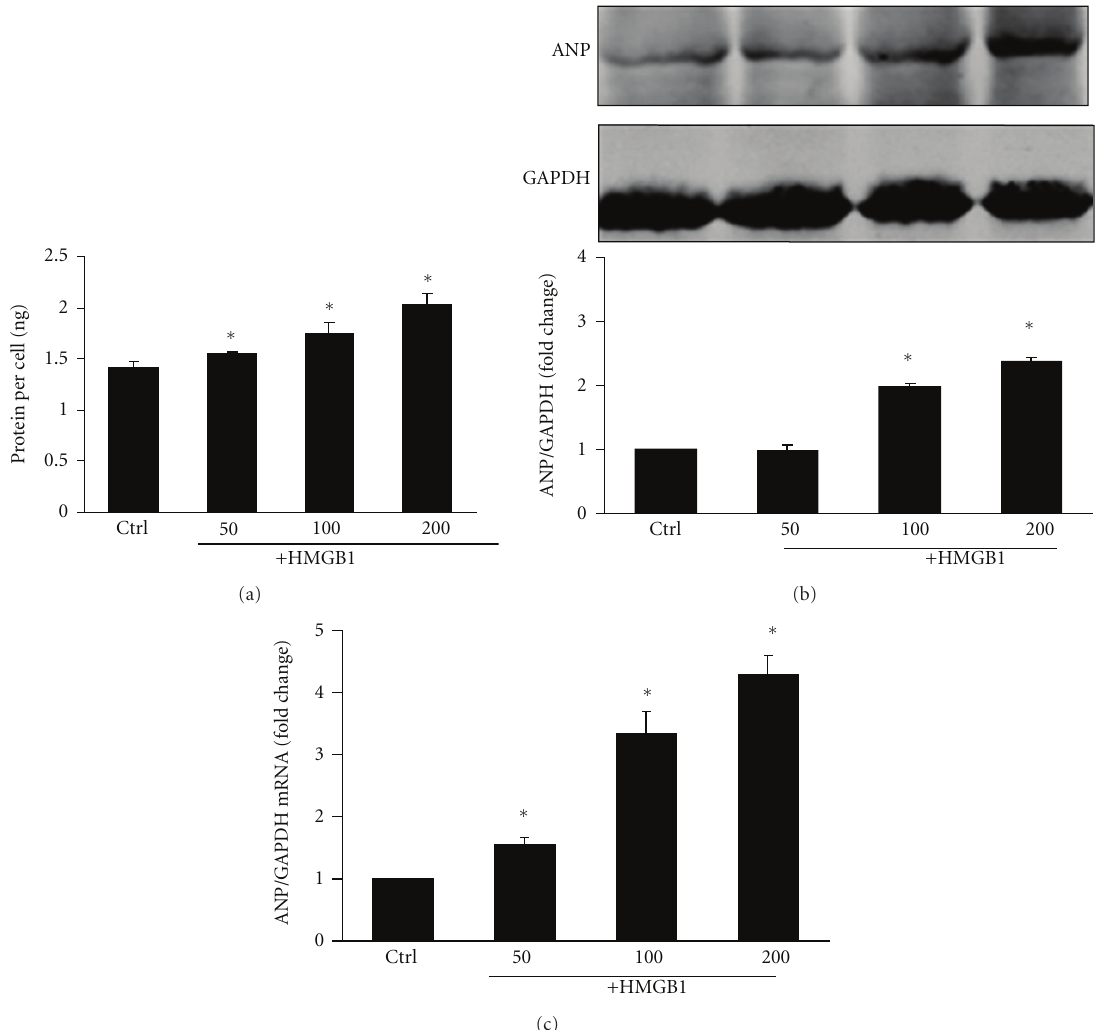
Figure 1: E ff ect of di ff erent concentrations of HMGB1 (50 to 200 ng/mL) on NRVM protein synthesis and ANP expression over 24hours. (a) NRVM protein synthesis was determined by measuring protein content per cell. (b) Expression of ANP protein in NRVMs was determined by Western blot analysis, and the integrated optical density (IOD) of ANP expression bands was analyzed. (c) Expression of ANP mRNA in NRVMs was determined by real-time RT-PCR. The bar graph represents three independent experiments. ∗ P < 0 . 05 versus control. Ctrl: control